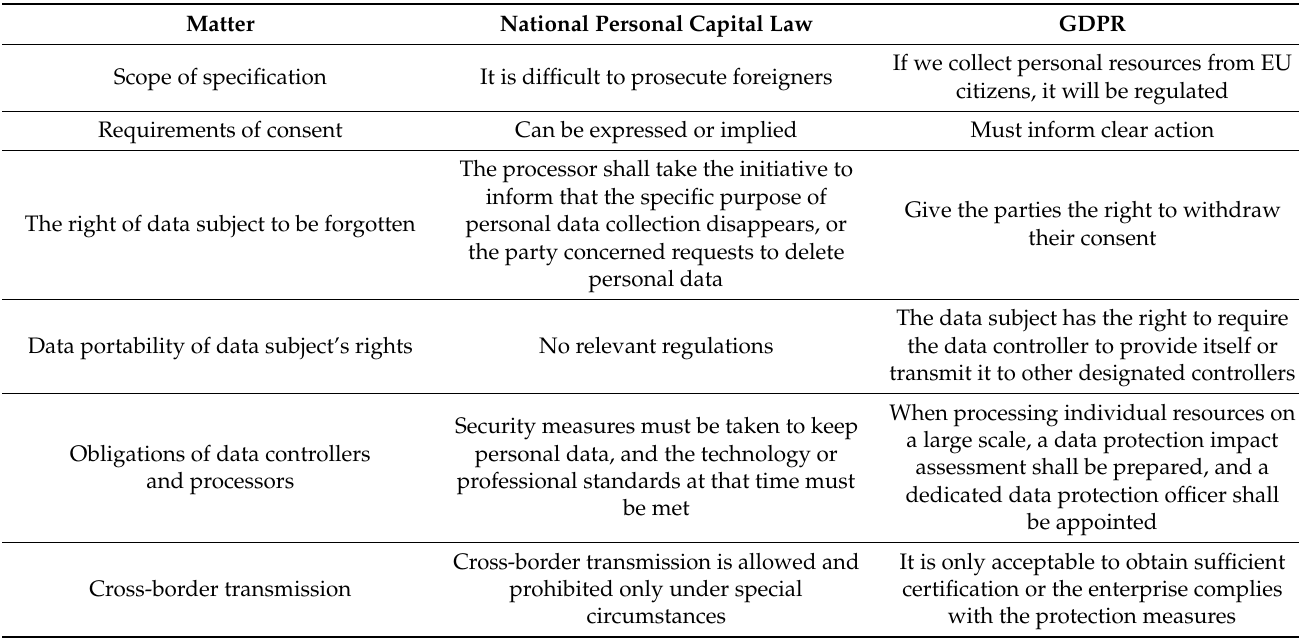
Table 1. Differences between China’s individual capital method and GDPR